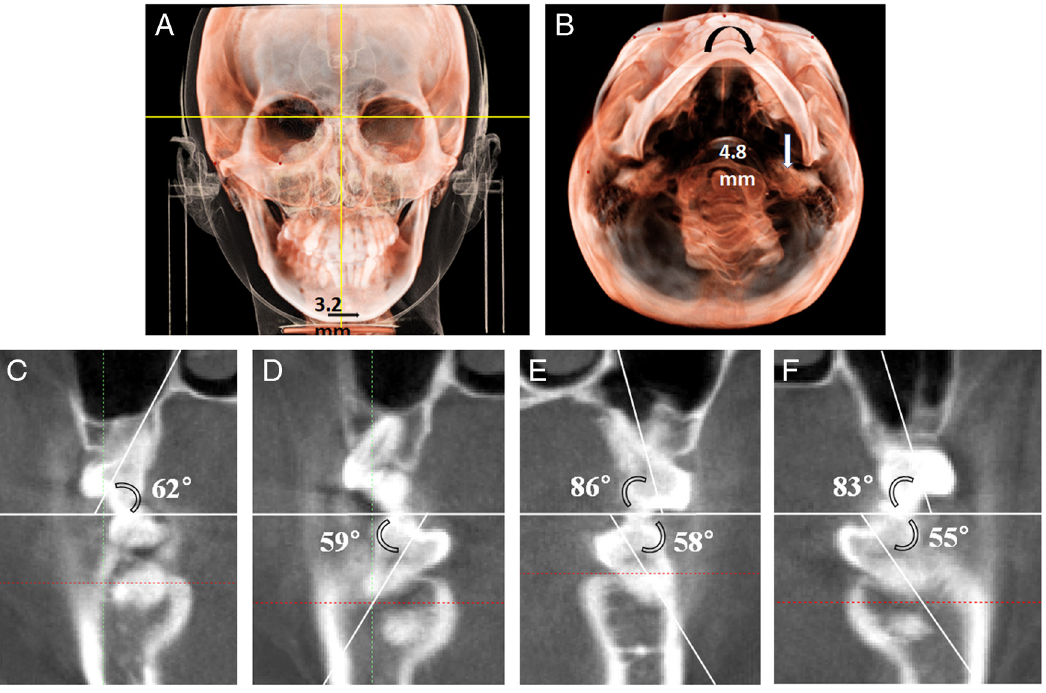
Figure 2. Pre-treatment cone-beam computed tomography. Top: (A) Frontal view, (B) Submentovertical view. The lower images are coronal section views showing the molar scissor-bite: (C) Severe buccal tipping of the maxillary right second molar, (D) Severe lingual tipping of the mandibular right second mo- lar, (E) Normal buccolingual angulation of the maxillary left first molar and severe lingual tipping of the mandibular left first molar, (F) Normal buccolingual angulation of the maxillary left second molar and severe lingual tipping of the mandibular left second